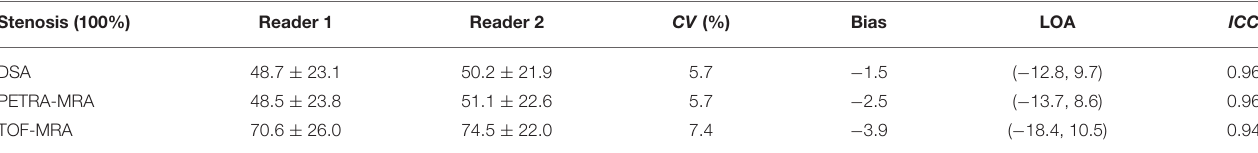
TABLE 4 | Summary of the inter-observer agreement for stenosis